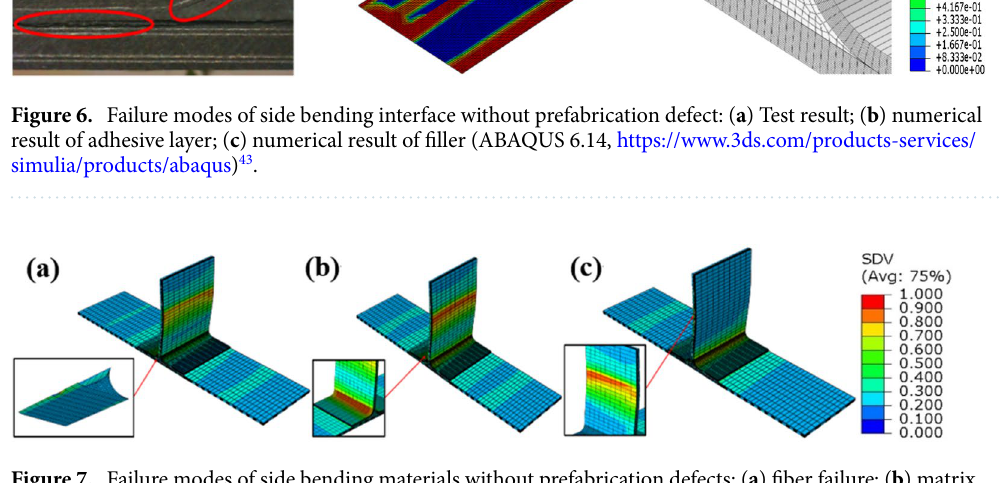
Figure 7. Failure modes of side bending materials without prefabrication defects: ( a ) fiber failure; ( b ) matrix failure; ( c ) fiber-matrix shear failure (ABAQUS 6.14, https:// www. 3ds. com/ produ cts- servi ces/ simul ia/ produ cts/ abaqus) 43 .